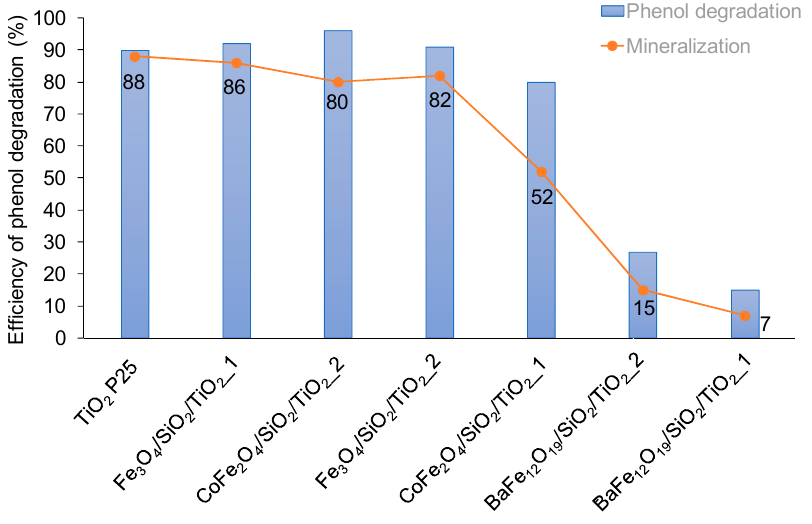
Figure 9. Efficiency of phenol degradation (C/Co) and mineralization (TOC/TOCo) of obtained magnetic photocatalysts.